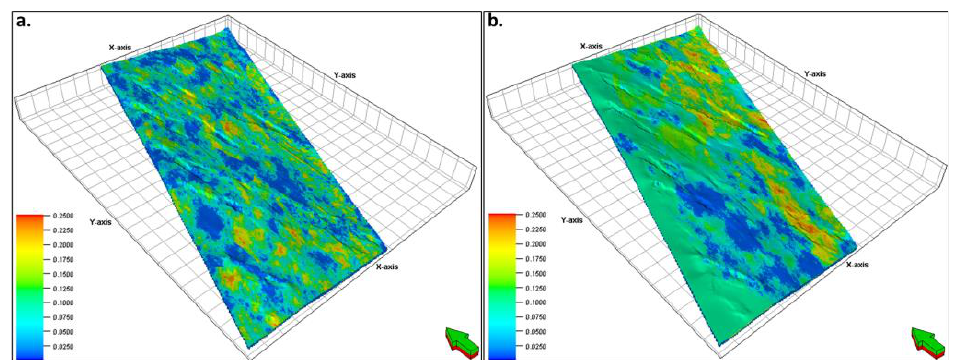
Figure 15. The trend derived from normalization of shale volume model. It is used as a constraint in porosity modeling. The PDF of the trend is shown on the left of the color bar.